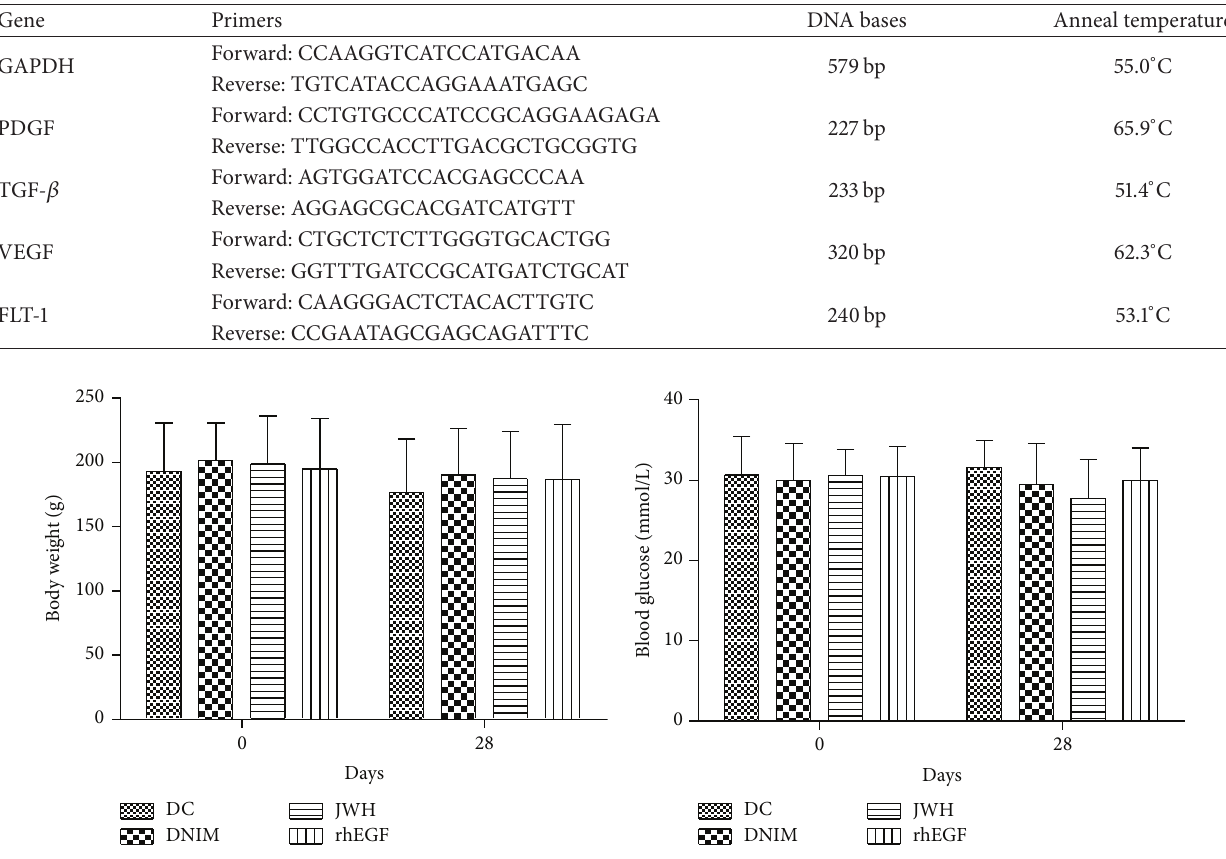
Table 1: Primers for PCR.